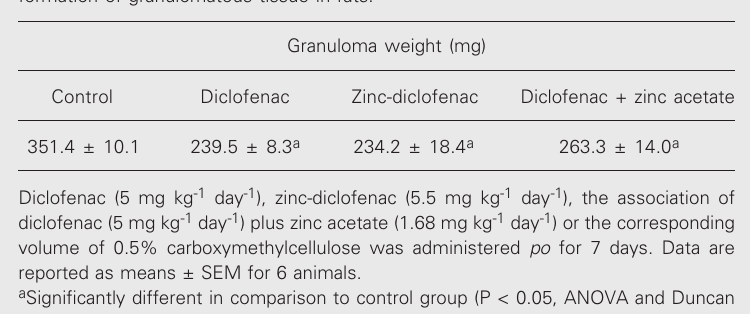
Table 1. Effect of diclofenac, zinc-diclofenac, and diclofenac plus zinc acetate on the formation of granulomatous tissue in rats.